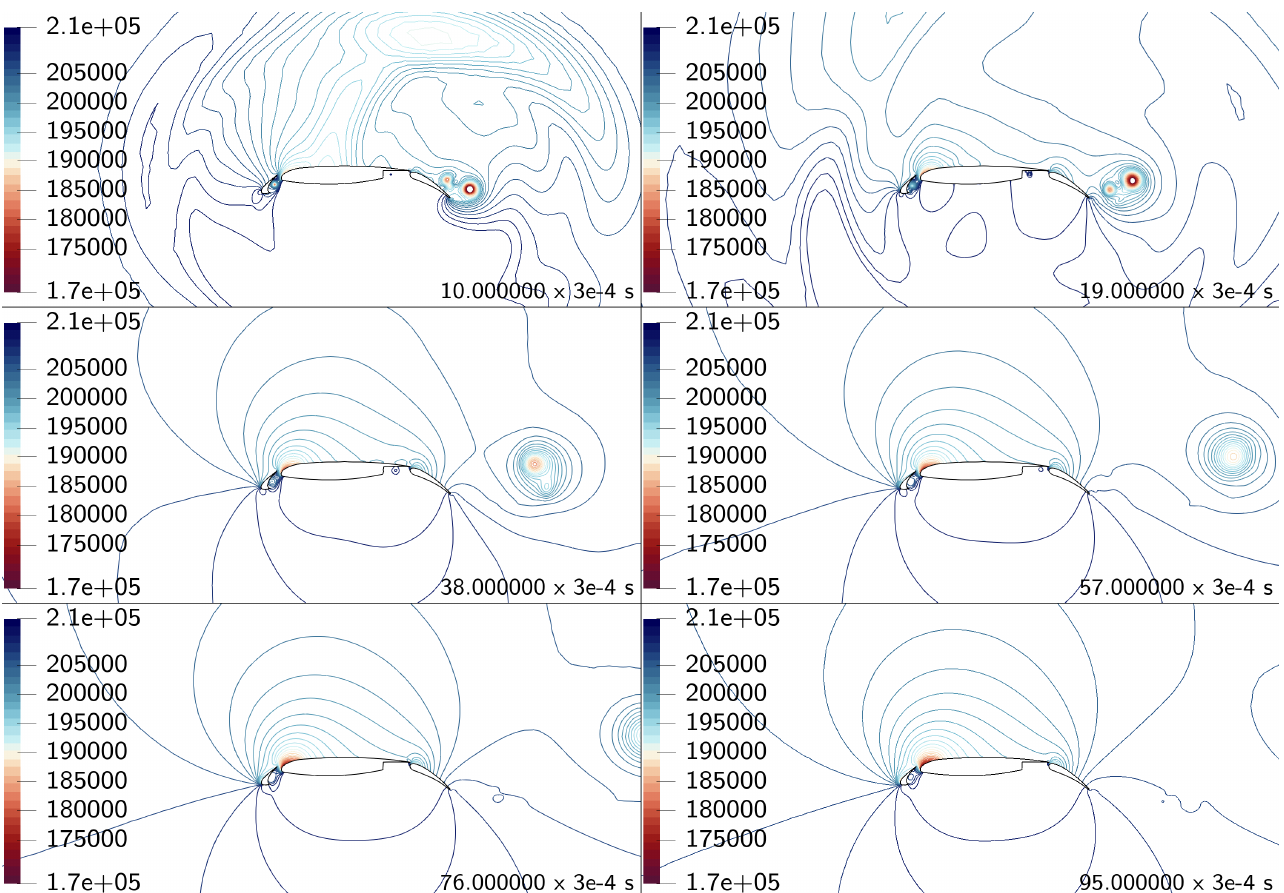
Figure 6. Contours of pressure for the impulsive start over the 30P30N airfoil at different instants of time.